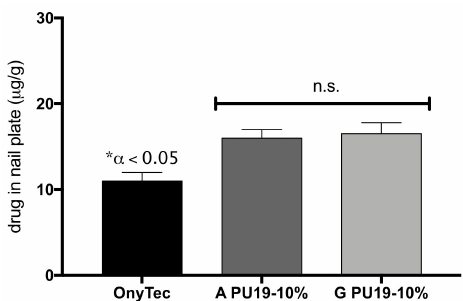
Figure 4. Amount of drug determined in nail plate after 11 days of experiments (mean ±